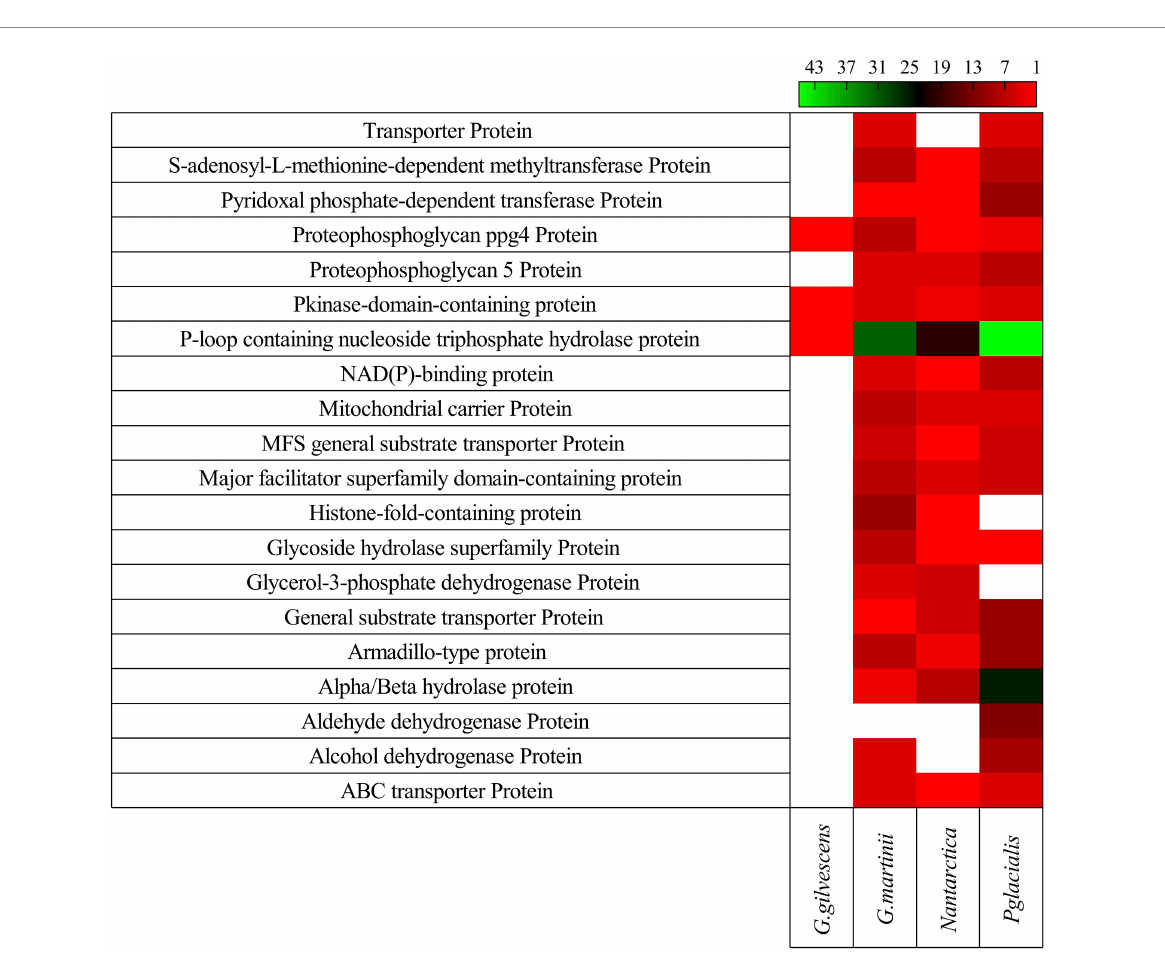
FIGURE 3 Gene redundancy for top 20 kinds of protein. The number of CDS predicted to encode for a protein in each yeast is